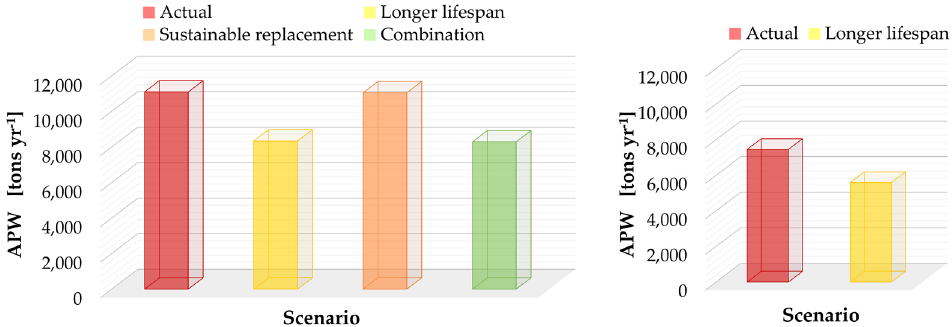
Figure 8. Distribution of the APW from covering films in the four municipalities in the scenario of longer lifespans (1st scenario).